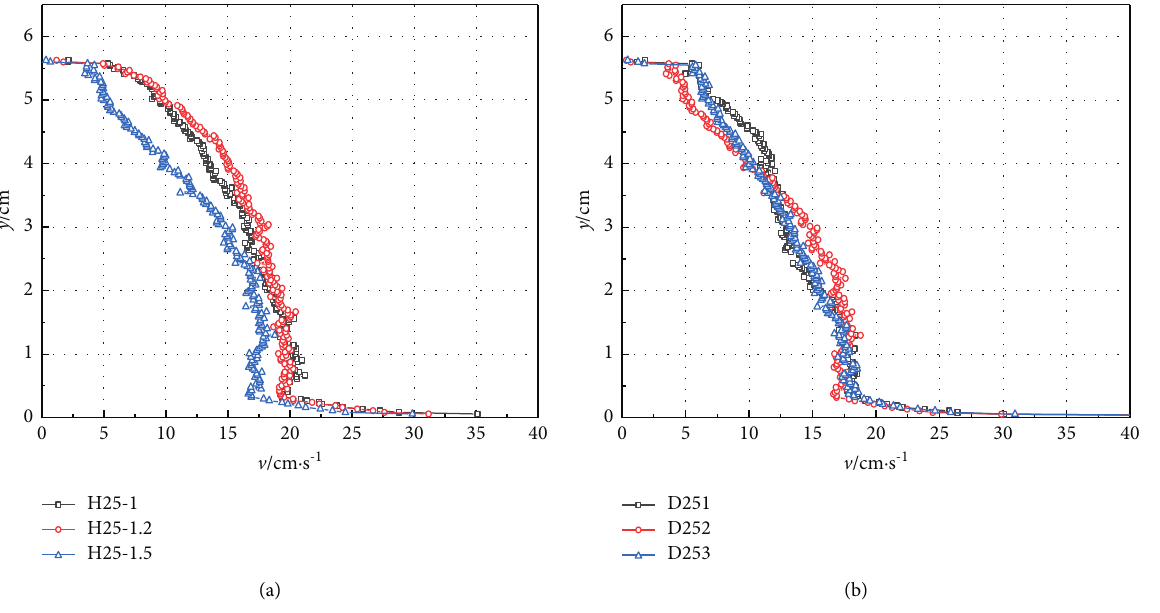
Figure 14: The vertical distribution of the vertical turbulent intensities in different working